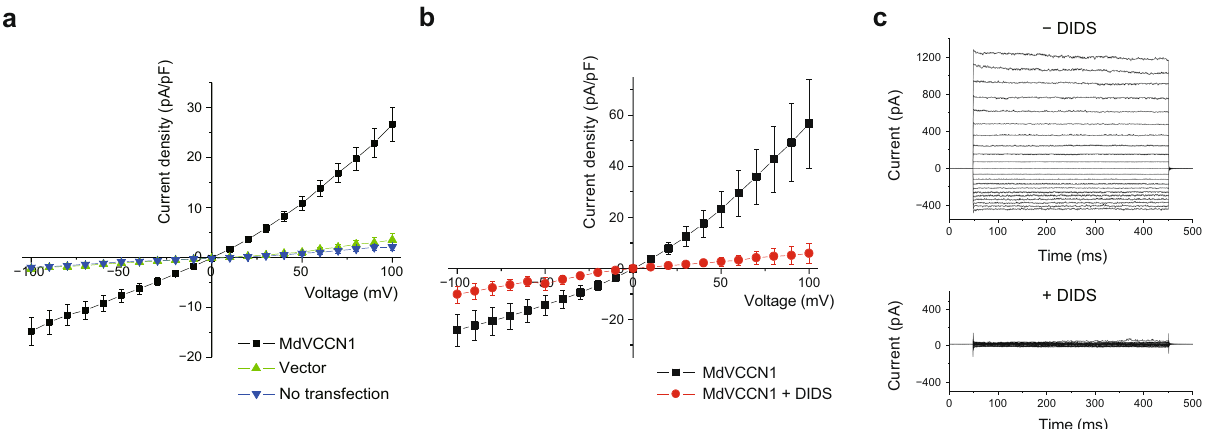
Fig. 1 Functional characterization of MdVCCN1. a Whole-cell current-voltage relationships in HEK293 cells expressing MdVCCN1 ( n = 7), expressing GFP by transfection of the empty GFP co-expression vector ( n = 10), and non-transfected HEK293 cells ( n = 9). Error bars represent s.e.m. Source data are provided as a Source Data fi le. b Whole-cell current-voltage relationships in HEK293 cells expressing MdVCCN1, before (black) and after (red) the addition of 0.5 mM DIDS ( n = 8). Error bars represent s.e.m. Source data are provided as a Source Data fi le. c Representative traces of whole-cell currents in HEK cells expressing MdVCCN1, before and after the addition of 0.5 mM DIDS to the bath solution. Source data are provided as a Source Data fi